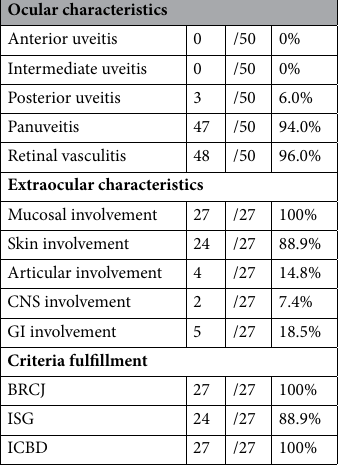
Table 1. Clinical features and criteria fulfillment. CNS: central nervous system, GI: gastrointestinal, BRCJ: Behçet’s Disease Research Committee of Japan, ISG: International Study Group, ICBD: International Criteria for Behçet’s Disease.